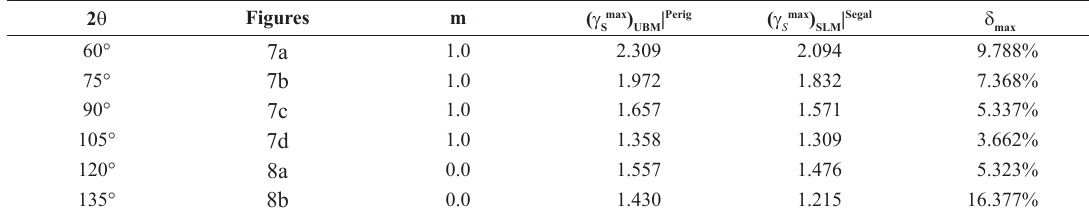
Table 2. Comparison of total plastic shears, derived by Perig’s upper bound and Segal’s slip lines solutions for different values of friction factor m